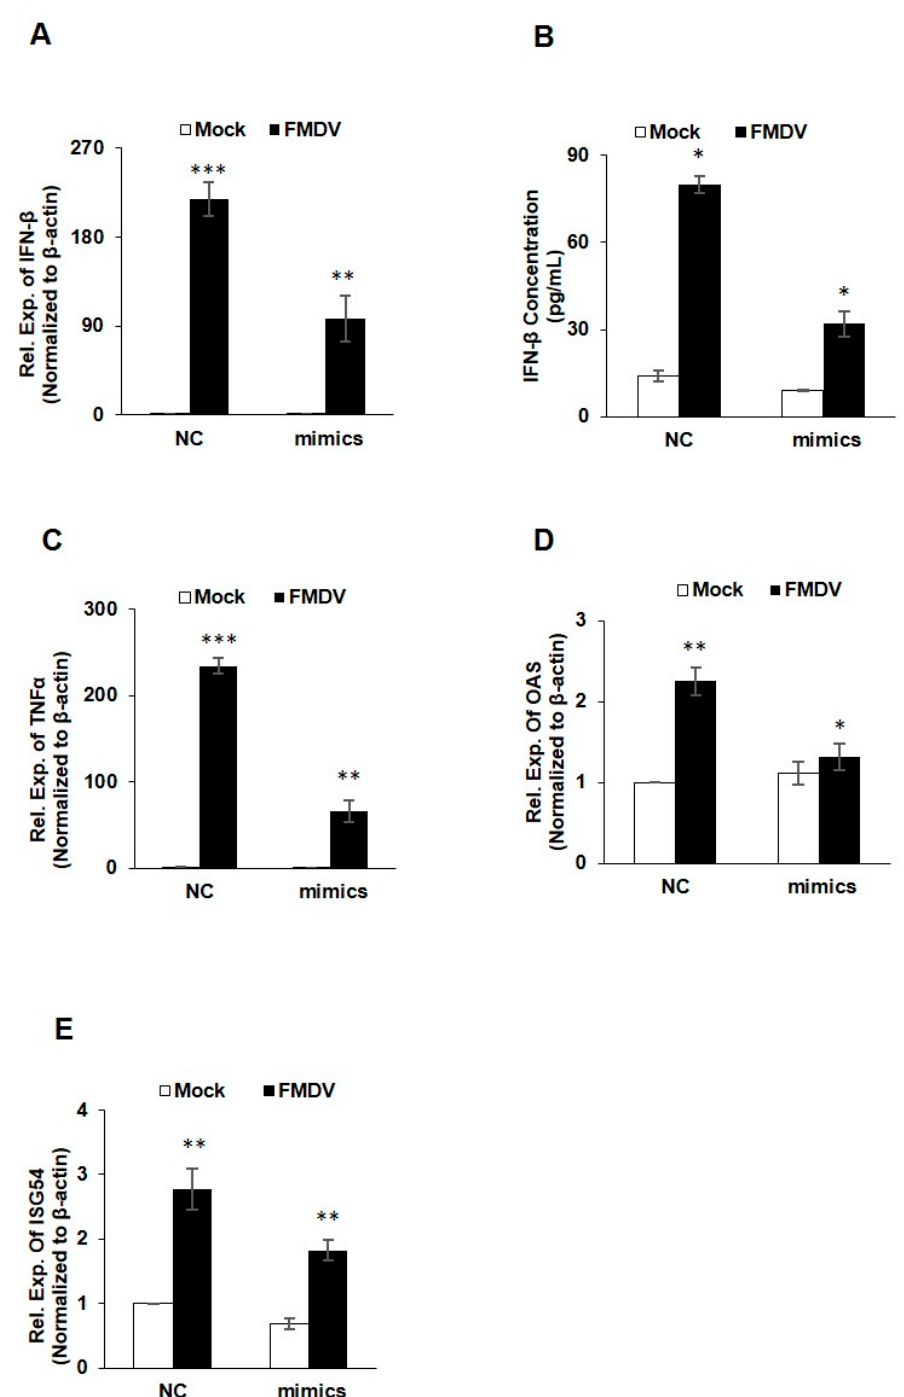
Figure 5. The interferon and antiviral genes expression were suppressed by miR-4334-5p via targeting ID1. ( A , B ). MiR-4334-5p mimics or scramble mimics (NC) were transfected into PK-15 cells for 24 h, respectively. Cell were infected with FMDV at 0.1 MOI for another 8 h. And then cells were harvested to detect the IFN- β expression level by qRT-PCR and IFN- β ELISA kit. Results shown are representative of three independent experiments, with each performed in triplicates. Bars represent SD of the mean. Asterisks indicate significance, according to Student’s t-test, ***, p < 0.001; **, p < 0.01, *, p < 0.05. ( C – E ). PK-15 cells were treated in the same way as in ( A , B ). Cells were harvested to quantify TNF α , OAS and ISG expression by qRT-PCR, β -actin was determined as an internal control. Results shown are means ± SD from triplicate assays. ***, p < 0.001; **, p < 0.01; *, p < 0.05.